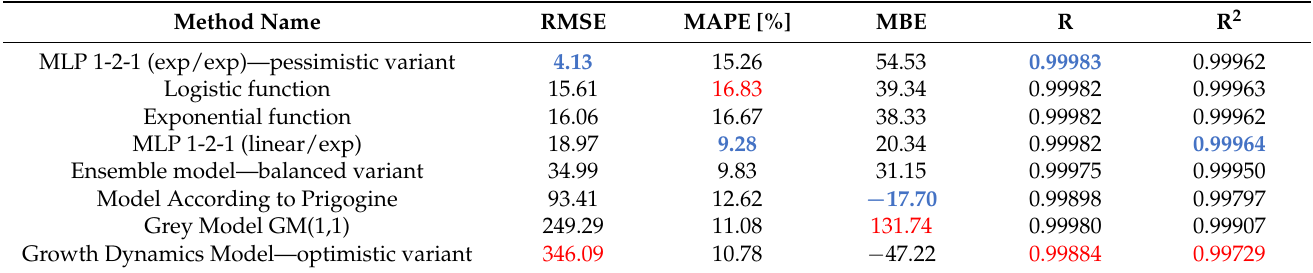
Table 2. Performance metrics in the model’s parameter estimation range for the forecast number of EVs.